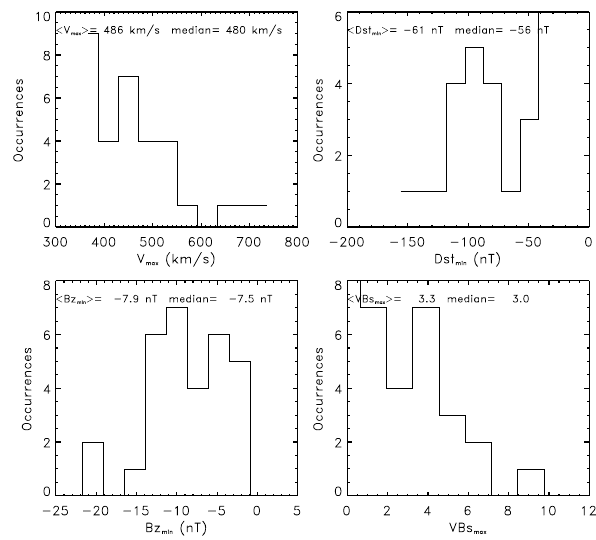
Fig. 4. Histograms of V max , D st , Bz min and V Bs max for MCs min during the quiet time of the solar cycle for the years 1965, 1966, 1975, 1976, 1985, 1986, 1996, 1997.